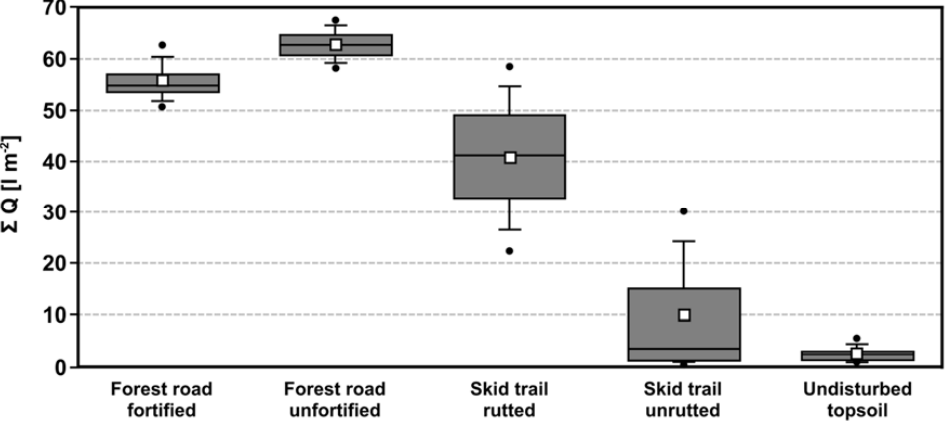
Figure 7. Boxplots of mean total runoff volumes ( t = 90 min) for different surface categories. Table 5. Mean total runoff volumes ( t = 90 min) and runoff coefficients for different surface categories.